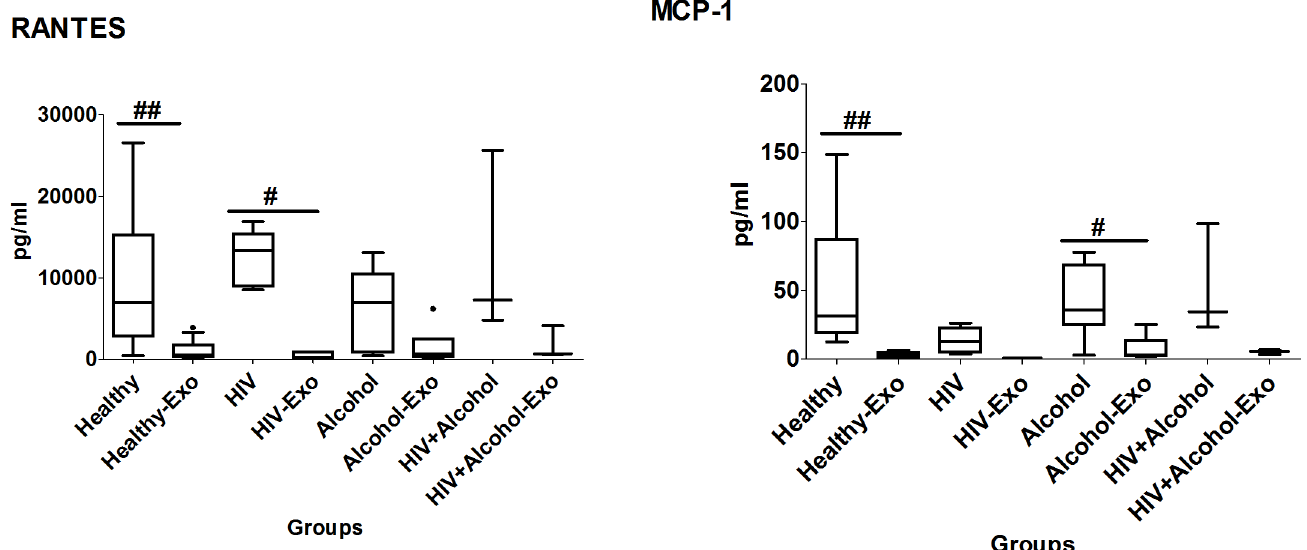
Fig 3. Box and whisker plots of anti-inflammatory cytokines between HIV-negative non-drug abusers (healthy), HIV-positive non-drug abusers (HIV), HIV-negative alcohol users (alcohol) and HIV-positive alcohol users (HIV+alcohol). The box represents the 25 th -75 th quartile, the whiskers represent the range of values, the median is presented as a line inside the box, and the out-of-range values are presented as circles. The Mann–Whitney U test was used to compare between plasma and exosomes of different study groups and significant p-values are represented as #-(p (cid:20) 0.05) and ##-(p (cid:20) 0.01). Comparison of cytokine levels among plasma as well as exosomes of different groups were done using Mann–Whitney U test and significant p-values are given as (cid:3) (p (cid:20) 0.05), (cid:3)(cid:3) (p (cid:20) 0.01) and $ (p (cid:20) 0.05), $ $ (p (cid:20) 0.01),